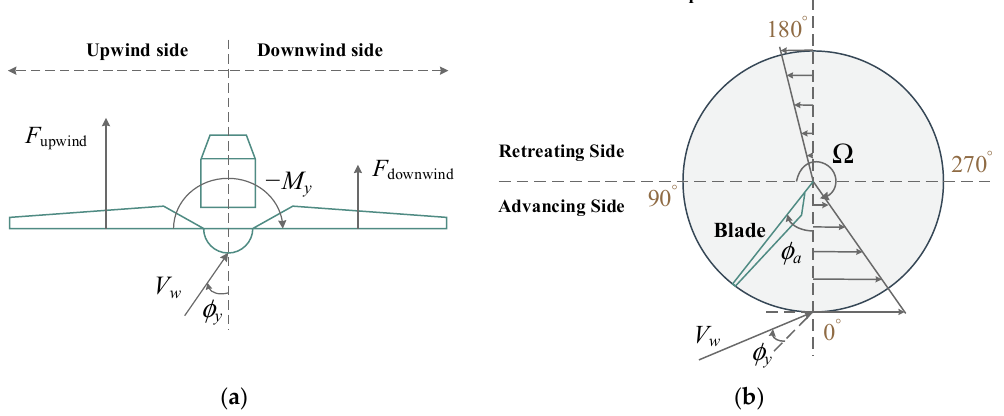
Figure 2. Schematic of a horizontal axis wind turbine under yawed inflow. ( a ) top view; ( b ) front view.